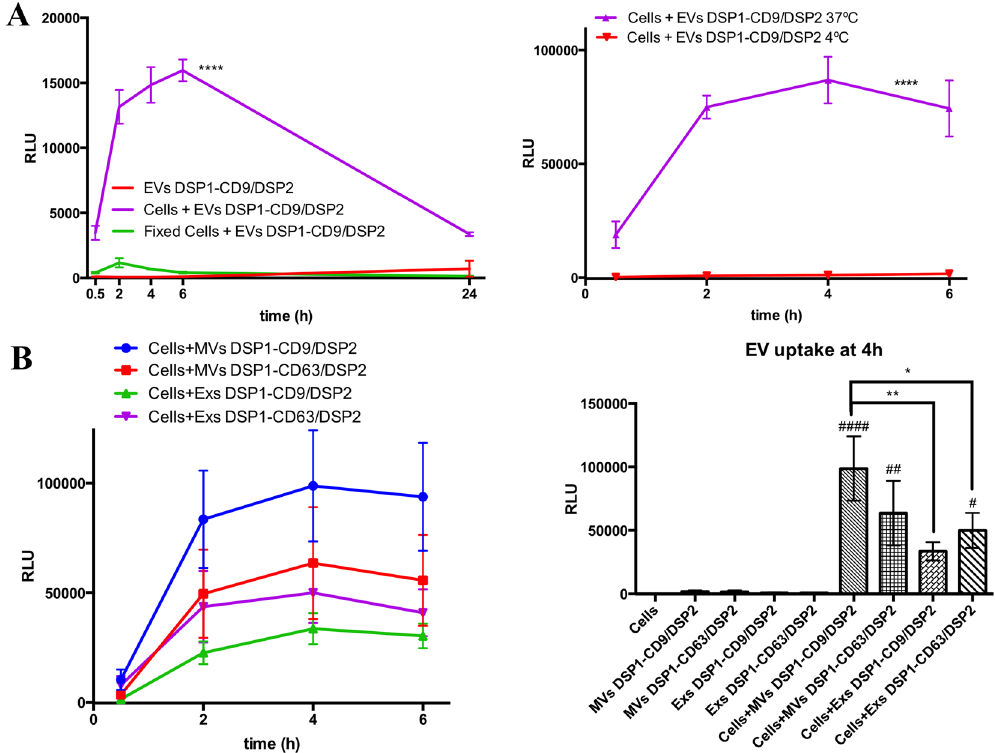
Figure 4. EV uptake assay characterization. ( A) EV uptake assays performed with receptor cells preloaded with Enduren and either fixed with 4% PFA (left plot) or performed at 4 °C (right plot). Statistics: **** comparison between non-fixed (purple) and fixed cells (green). Two way Anova, Tukey’s multiple comparison test. n = 4. EV uptake assay performed at 37 °C or at 4 °C (right plot). Statistics: **** compared to positive control at 37 °C (purple). Two way Anova, Dunnett’s multiple comparison test, n = 3. (B) EV uptake assay with EVs obtained by differential ultracentrifugation. Microvesicles (MVs) or Exosomes (Exs) from DSP1-CD9/ DSP2 or DSP1-CD63/DSP2 cells were used. EV uptake kinetics are represented in the left plot. Bar plot of EV uptake signal at 4 h including all negative controls is shown in the right plot. 5.58 × 10 9 EVs of each type were used per well. Statistics: ** , * comparison between EV types; ####,##,# comparison with all the controls; p values = 0.0034 ** , 0.0395 * , < 0.0001####, 0.0019##, 0.0311#. Two way Anova, Tukey’s multiple comparison test. n =